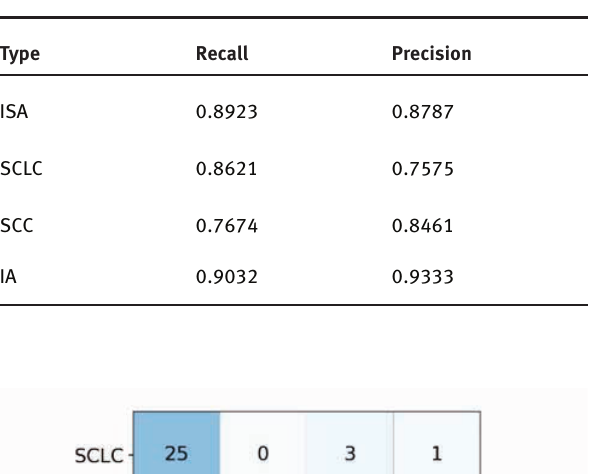
Table 3: Proposed CT lung image classification with transfer learn- ing results